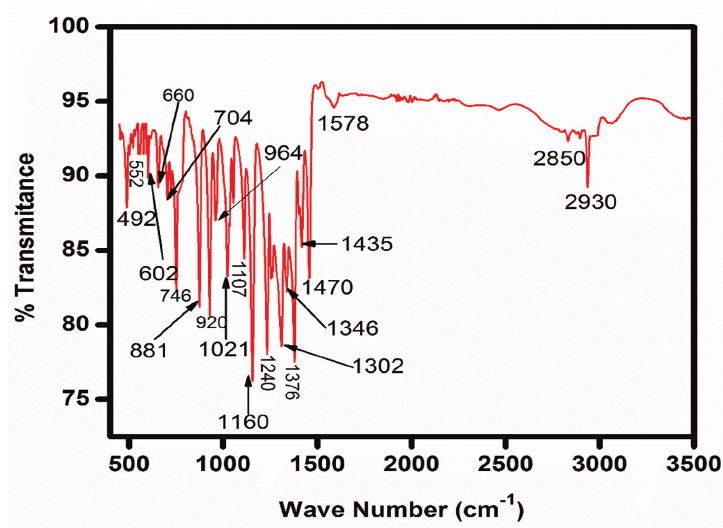
Figure A6: FT-IR spectrum of synthesized precursor 2.